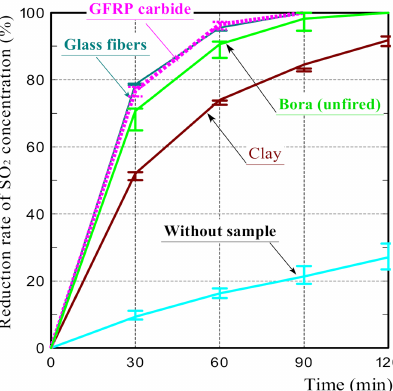
Figure 9. The reduction rates of SO 2 concentration on the glass fiber and the carbide of